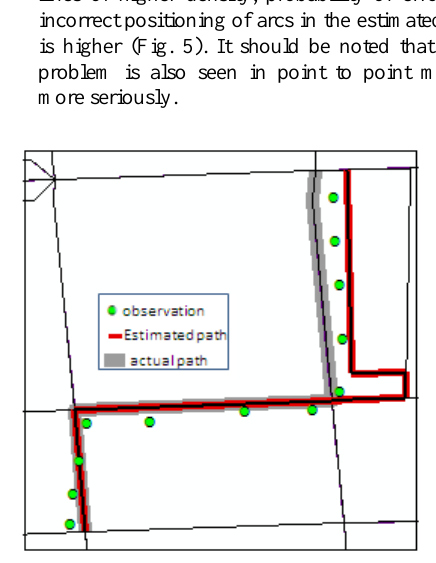
Figure 5. Incorrect path estimation due to high density of network lines